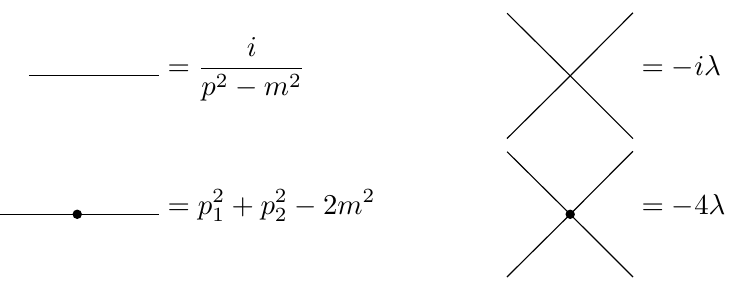
Figure 3 . Feynman rules for (cid:30) 4 theory and insertions of the operator (cid:18) , represented by a solid dot.